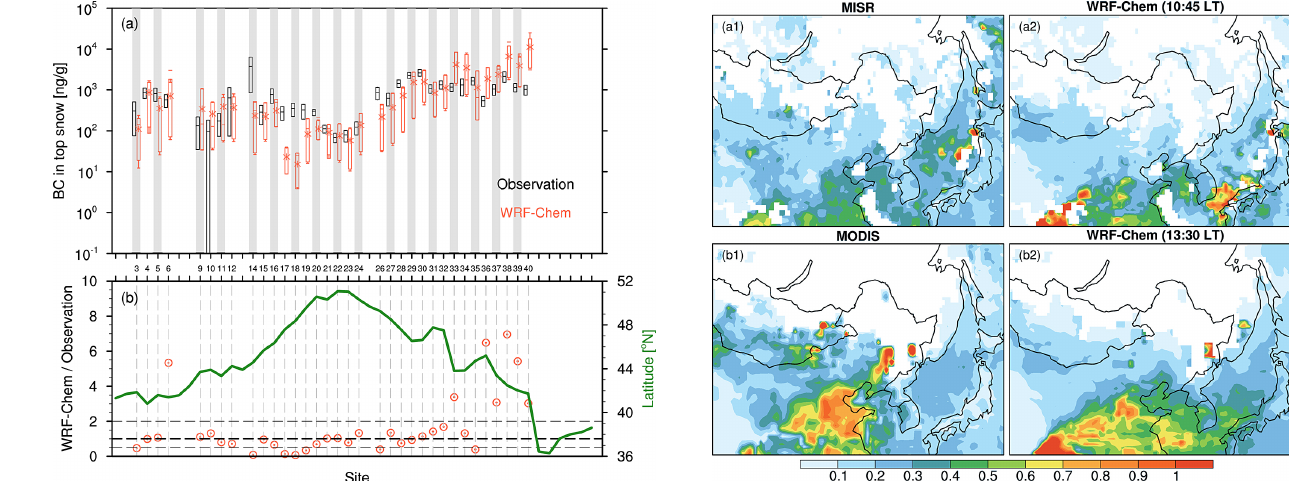
Figure 8. Spatial distribution of AOD over North China in January– February 2010 from the MISR and Aqua-MODIS retrievals and the corresponding WRF-Chem simulations. The model results are sampled at the MISR ( ∼ 10:45LT) and Aqua-MODIS ( ∼ 13:30LT) overpass time, respectively, at the locations where retrievals are